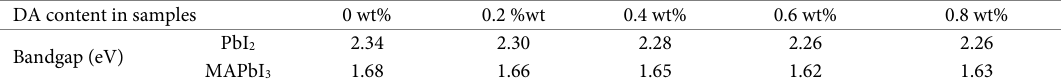
films doped with various concentrations of DA deposited on top of 3